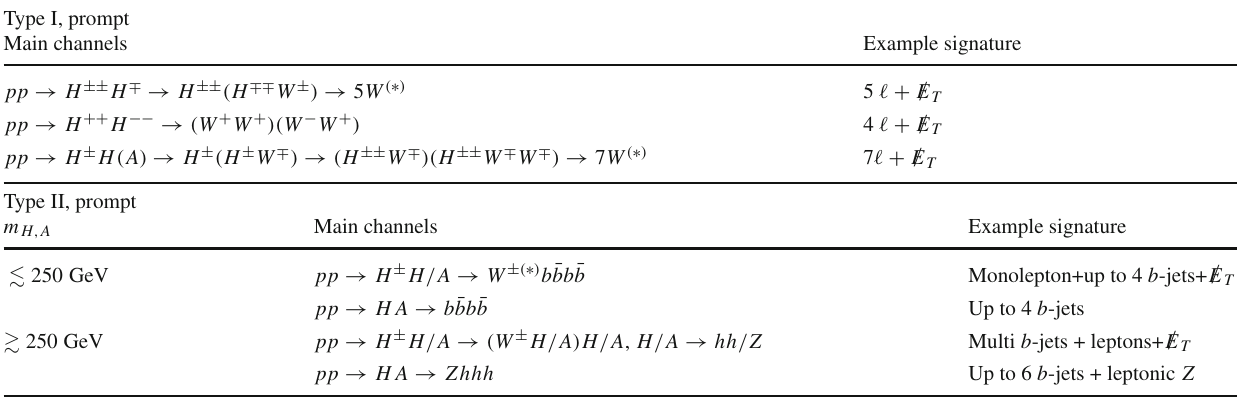
Table 2 Summary of main channels and example search signatures for additional Higgs bosons of the HTM that promptly decay at the LHC. The upper and lower tables consider the type-I and II HTM, respectively. See text for more details Type I, prompt Main